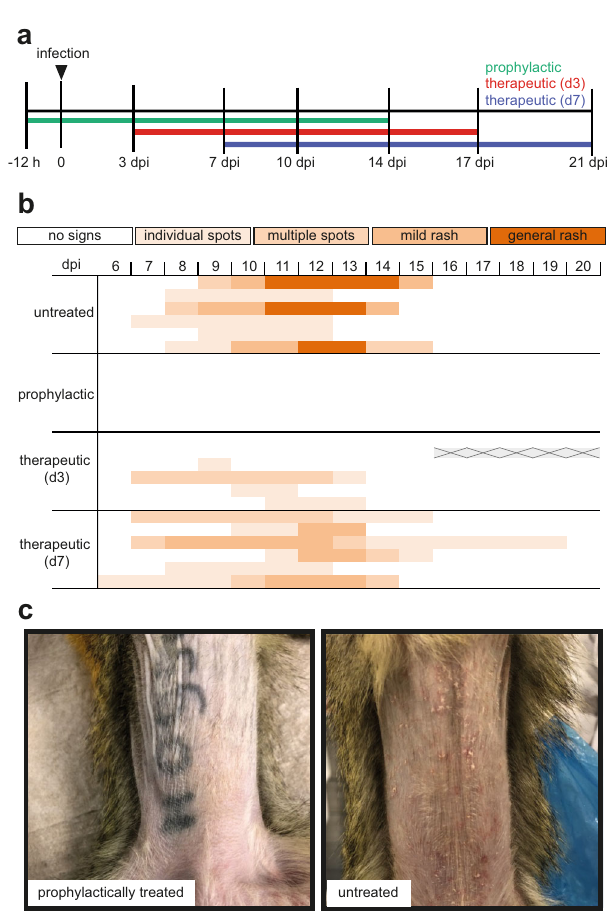
Fig. 2 Effect of ERDRP-0519 on manifestation of clinical signs in MeV- infected squirrel monkeys. a Schematic illustration of the experimental design. Each group was treated twice daily ( b.i.d. ) over a 14-day period, illustrated by colored lines. Prophylactic treatment started 12 h prior to infection (green); therapeutic treatment started on day 3 post-infection (therapeutic (d3), red), or on day 7 post-infection (therapeutic (d7), blue). Dpi, days post-infection. b Clinical scores of infected animals. Each row represents one animal of the respective group and color intensity indicates severity of clinical signs categorized as no signs (white) or individual spots, multiple spots, mild rash, and general rash (light to dark graduation). Gray, crossed areas represent deceased animal. c Representative photographs of the abdomen of a prophylactically treated animal (left) and an untreated animal (right), taken 13 days